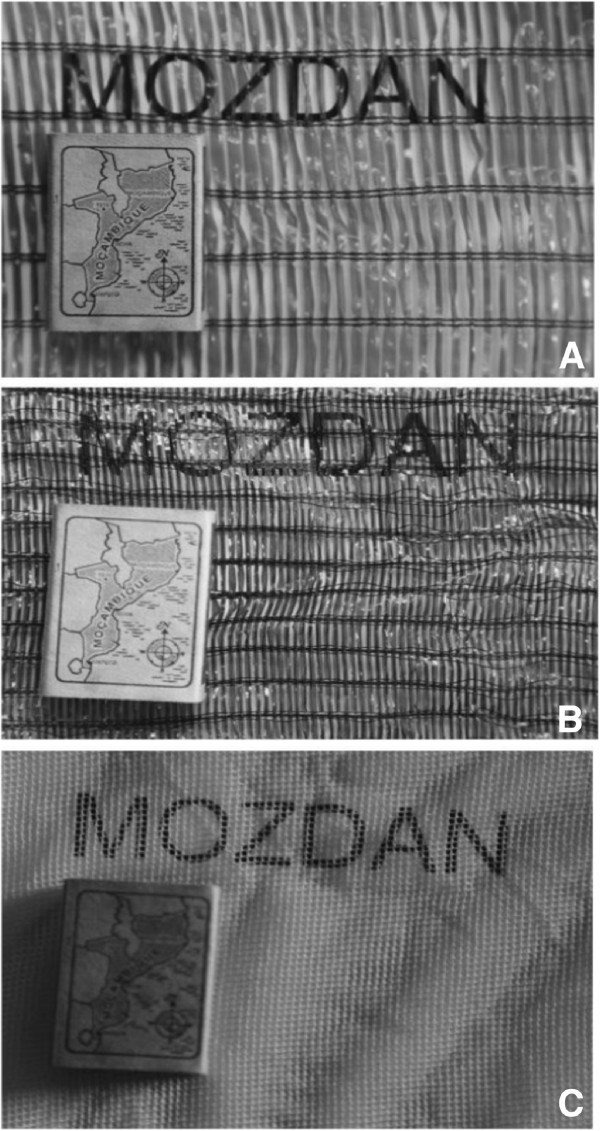
A) Photograph of Zero Vector material used in the experiment. B) Photograph of Maxixe material used in the experiment. C) Photograph of the netting used in the present experiment.